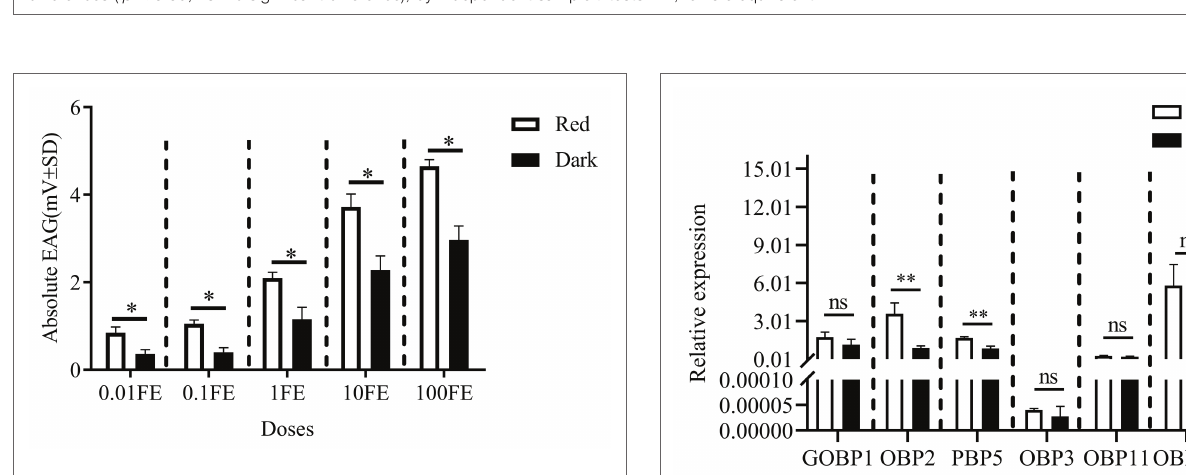
FIGURE 5 | Electroantennographic (EAG) responses of male C. punctiferalis reared under red light and dark conditions during scotophase. (A) E10-16 ∶ Ald; (B) Z10-16 ∶ Ald; (C) Z9-27 ∶ HC Z6; and (D) Z3, Z6, Z9-23 ∶ HC. Data are shown as mean ± SD, from four replicates. Asterisks above columns mean significant differences ( * p < 0.05, ns: no significant difference), by independent sample t -tests. FE, female